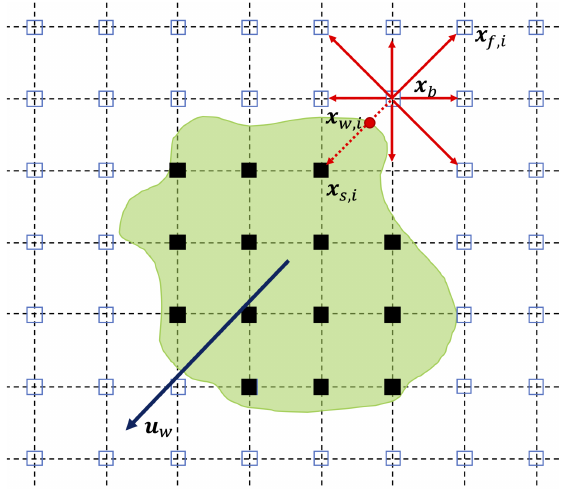
Figure 1. Obstacle definition into fluid domain. Empty squares represent the fluid nodes, filled squares belong to the obstacle; the red filled circle represents the exact wall position along the ith lattice direction. Continuous red arrows represent the known populations, while the dashed ones represent the ones to be reconstructed before